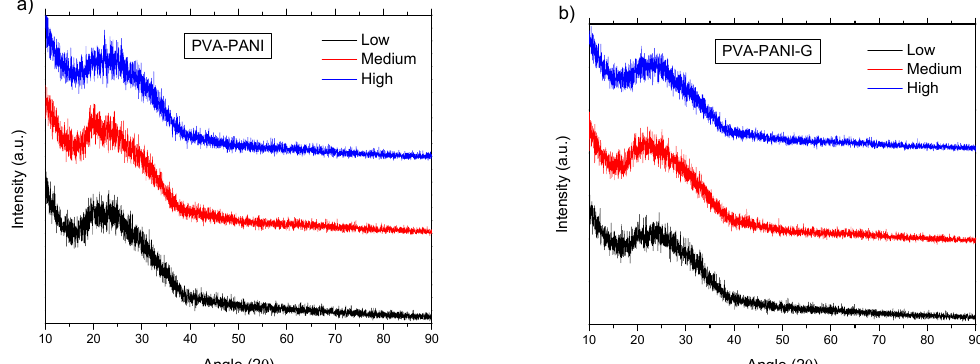
Figure 16. XRD diffractogram of ( a ) PVA–PANI thin films at different concentrations of aniline and ( b ) its comparison with PVA–PANI-G thin films.